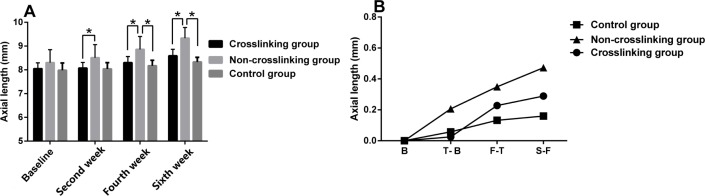
The comparison of axial length (A) between the three groups. Top of the box plot represents the mean and the bar of each box represents the standard deviation. The trend graph of axial length (B). Triangle, square and circle represent the means. *Statistical significance (p < 0.05) between the groups. B: the value of axial length (baseline); T-B: the value of axial length change (second week minus baseline); F-T: the value of axial length change (fourth week minus second week); S-F: the value of axial length change (sixth week minus fourth week).